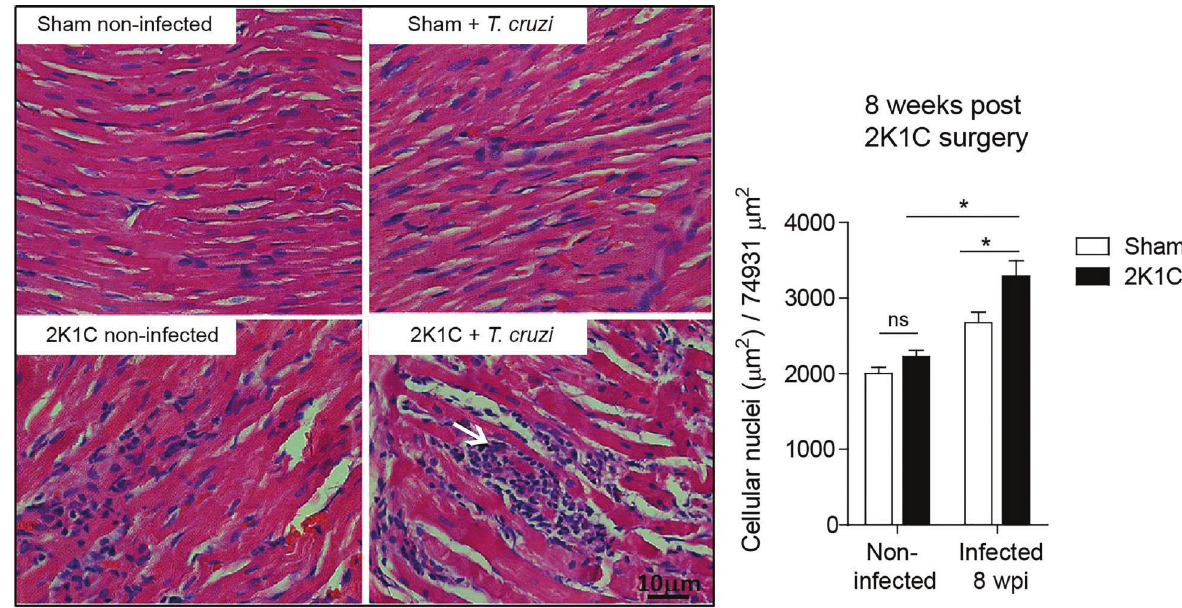
Figure 4. In fl ammatory leukocytes in two-kidney one-clip (2K1C) infected cardiac tissue. Before and eight weeks after 2K1C (n=8) and Sham (n=8) surgeries, immediately followed, or not, by infection with the Y strain of T. cruzi , cardiac tissues were stained with hematoxylin and eosin to quantify cellular nuclei (from leukocytes and cardiac cell nuclei). This analysis was performed using the ImageJ program in a total area of 74,931 m m 2 (magni fi cation 40 (cid:1) ). Data are reported as means ± SE. *P p 0.05, one-way ANOVA followed by Bonferroni post-test. ns: non-signi fi cant difference. White arrow: leukocyte in fi ltration. wpi: weeks post-infection. Magni fi cation bar: 10 m m.